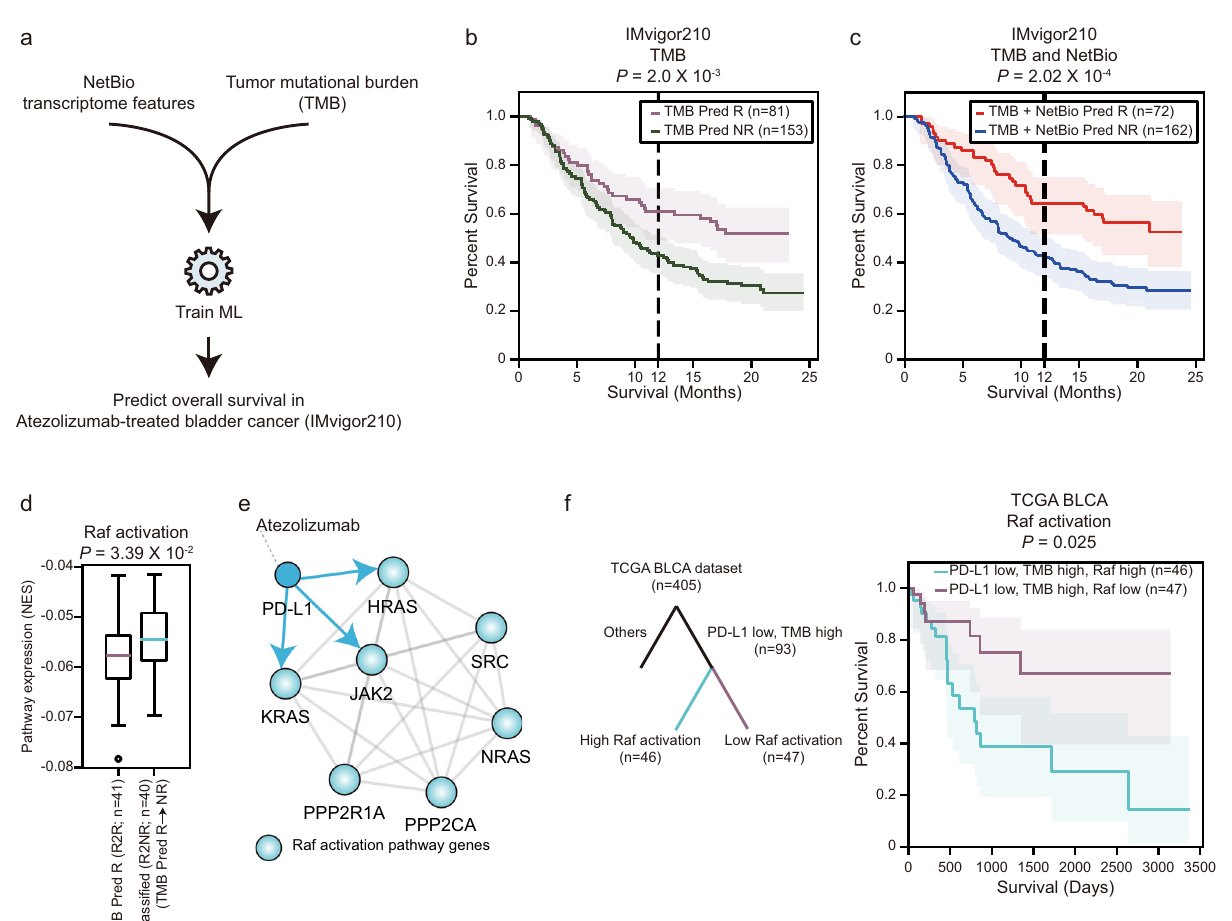
Fig. 7 Combining network-based transcriptome features and the tumor mutation burden (TMB) improves the prediction of the overall survival in PD- L1 inhibitor (atezolizumab)-treated bladder cancer patients. a Overall scheme of the network-based transcriptome and TMB combined predictions. b , c Prediction of the overall survival using ( b ) TMB-only and ( c ) a combined ML model. Statistical signi fi cance was measured using the log-rank test. The light-colored areas indicated 95% con fi dence interval of each percent survival. d Differential expression of the Raf activation pathway between predicted responders from TMB-only predictions and the reclassi fi ed subgroup from combined ML model predictions. Boxplot shows median value, interquartile range (IQR) as bounds of the box and whiskers that extends from the box to upper/lower quartile ± IQR × 1.5. The two-sided Student ’ s t test was used for statistical signi fi cance. e Network representation of the atezolizumab target (PD-L1) and Raf activation pathway. f Association between PD-L1 expression, the TMB levels and the expression levels of the Raf activation pathway with overall survival in bladder cancer patients (TCGA BLCA dataset). The light- colored areas indicated 95% con fi dence interval of each percent survival. Source data are provided as a Source Data fi